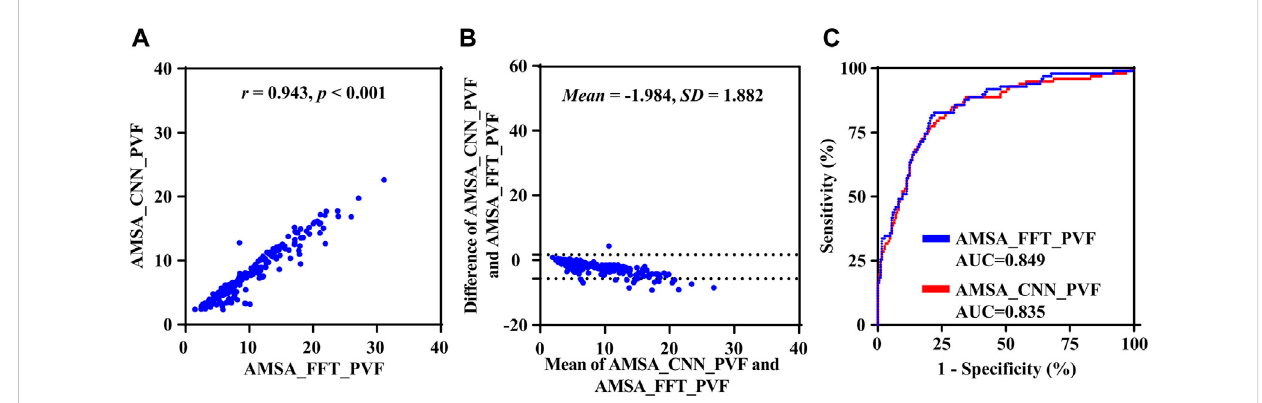
Performance results of the proposed method on preshock data. (A) Relationship, (B) difference and (C) receiver operating characteristic curve between AMSA_CNN and AMSA_FFT.